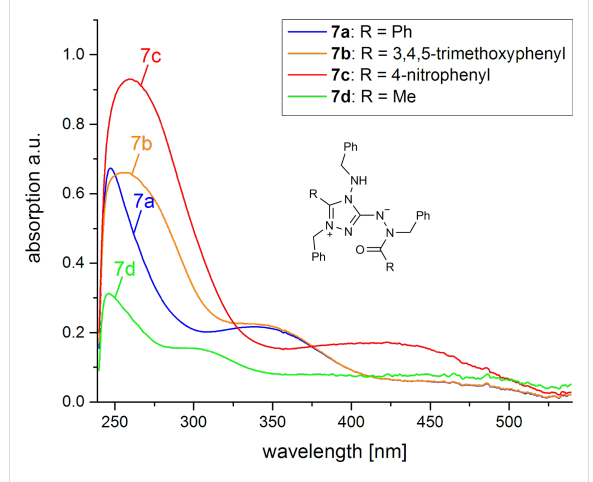
Figure 5: UV–vis spectra of 7a–d in chloroform ( c = 0.04 mmol L − 1 );